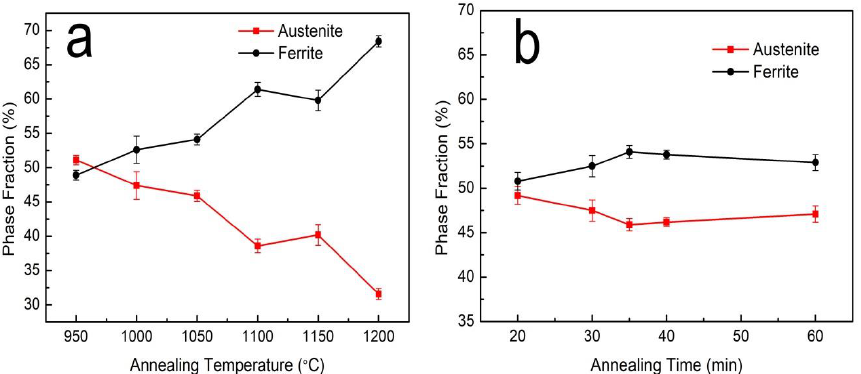
Figure 3. The ferrite and austenite phase fraction at different annealing ( a ) temperatures and ( b ) times. The average and standard deviation values (scatter band) of the phase fraction were obtained from 5 experiments.